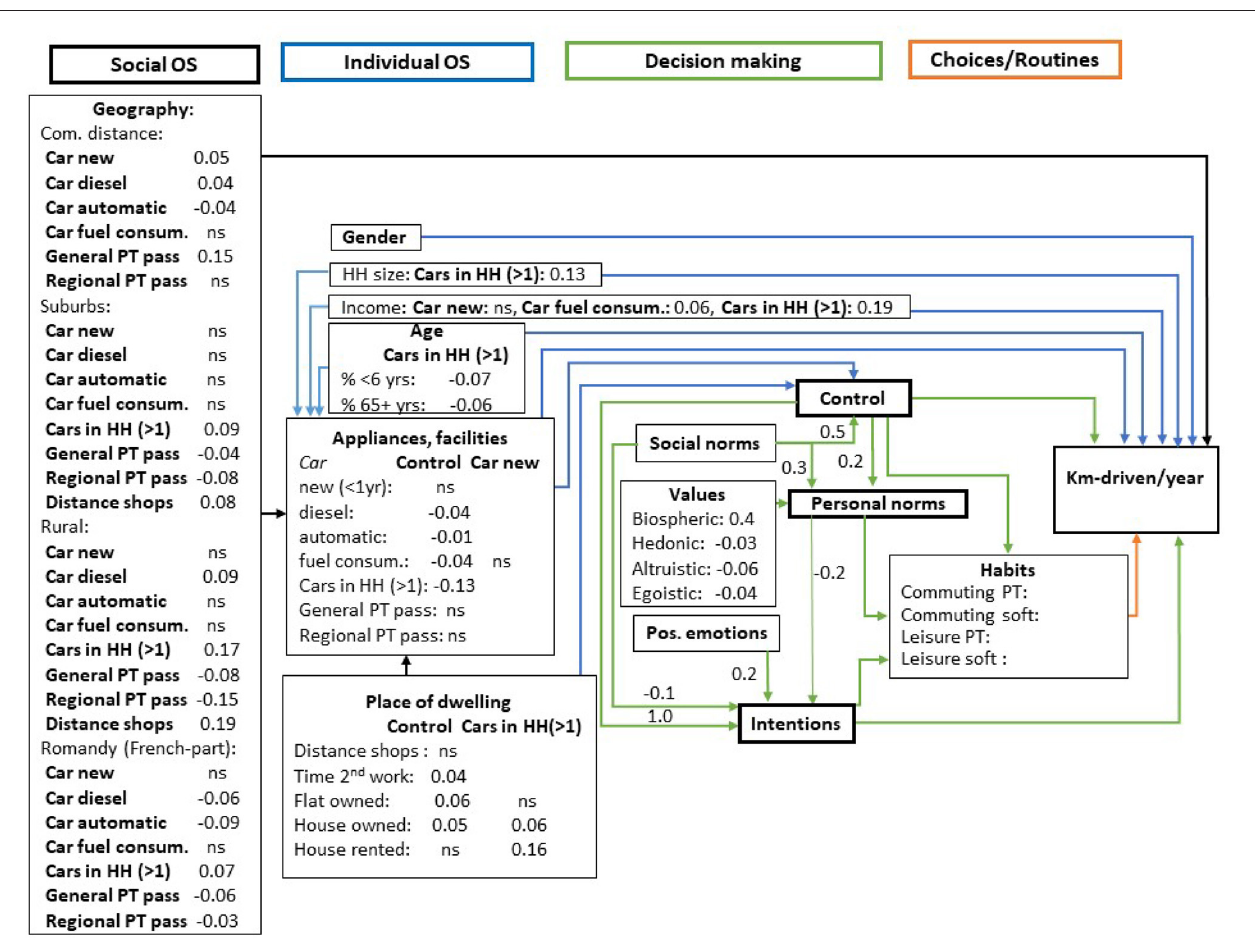
FIGURE 6 | Direct pathways explaining IOS and SOS factors. Reported are standardized direct coefficients with p < 5% (complete results are provided in Table A5 ), ns = not significant at 5%; bold variables = explained